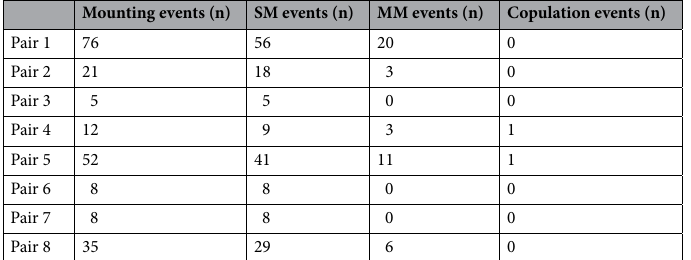
Mounting events (n) SM events (n) MM events (n) Copulation events